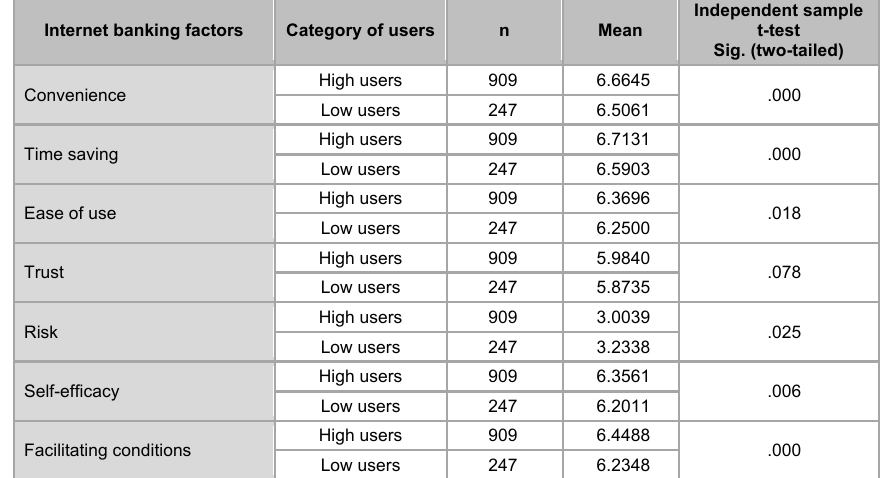
Results of independent sample